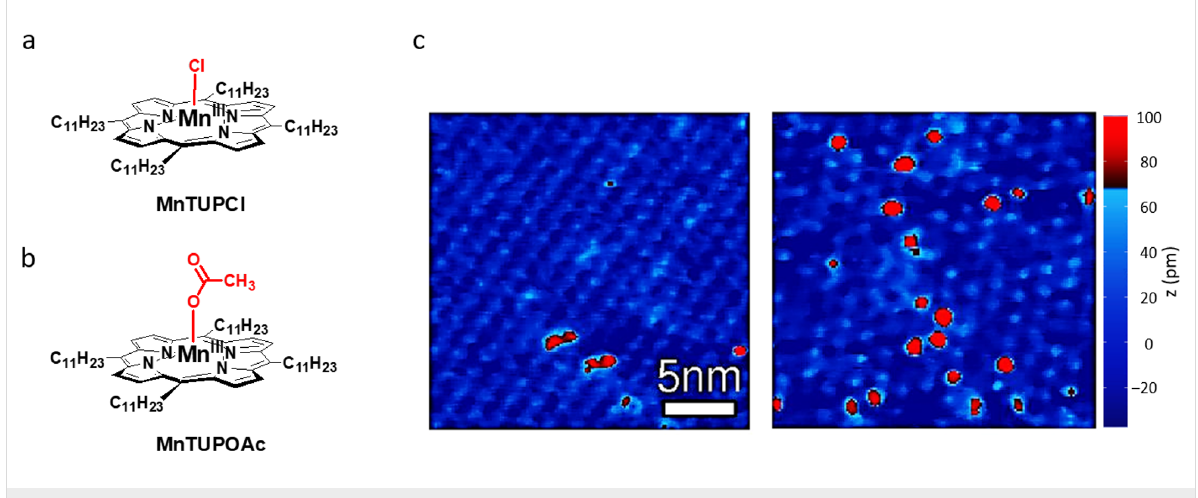
Figure 1: (a) Molecular structure of MnTUPCl . (b) Molecular structure of MnTUPOAc . (c) STM images of a monolayer of MnTUPCl at a Au(111)– n -tetradecane interface; the light blue spots are the native MnTUPCl molecules, the red spots their respective Mn=O complexes; left image: in argon atmosphere, a few Mn=O species are present; right image: in oxygen atmosphere, more Mn=O species have been formed. The color bar on the right indicates apparent heights. The STM images were adapted from our previous work